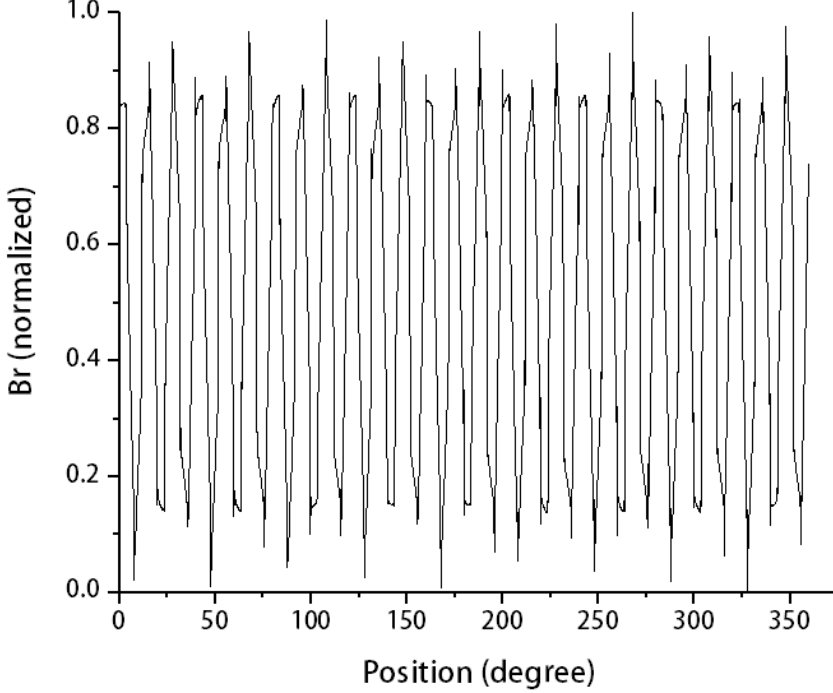
Figure 10. The distributions in space of radial flux density in air gap under 0.15 mm eccentricity. (whole